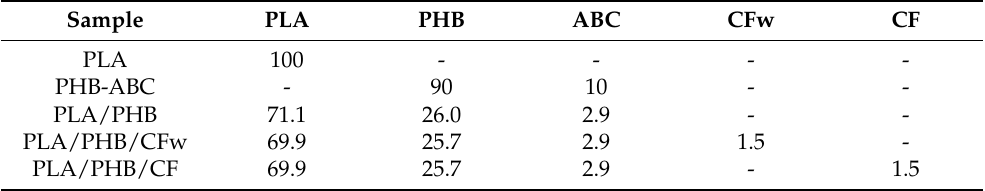
Table 1. Composition of the